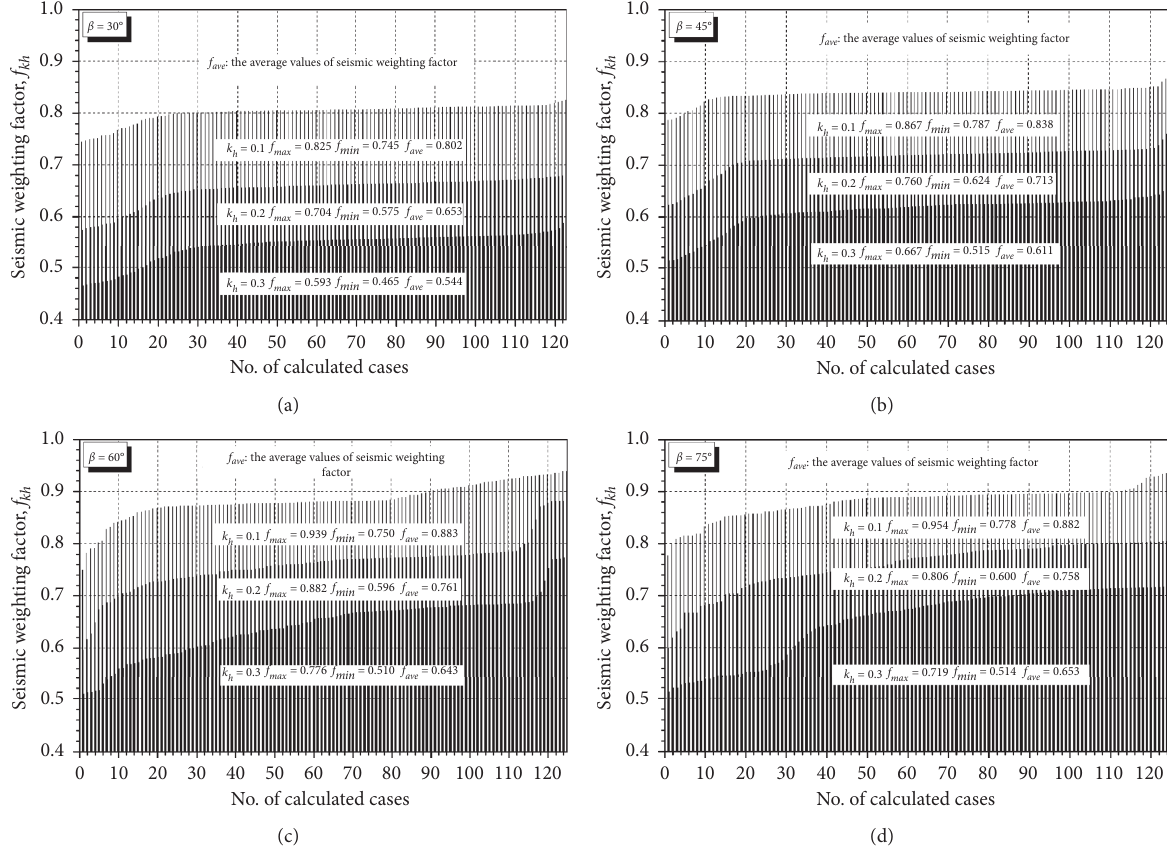
Figure 8: The seismic weighting factors for rock slopes with (a) β � 30 ° , (b) β � 45 ° , (c) β � 60 ° , and (d) β � 75 ° . Table 3: Regression equations for the seismic weighting